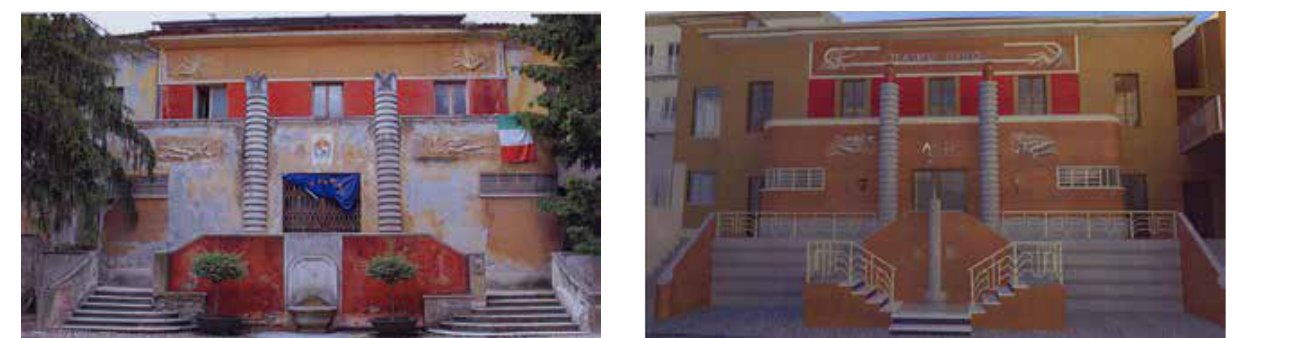
Figure 14. Current photograph of main façade of the 'Teatro civico di Susa' by Otto Maraini.